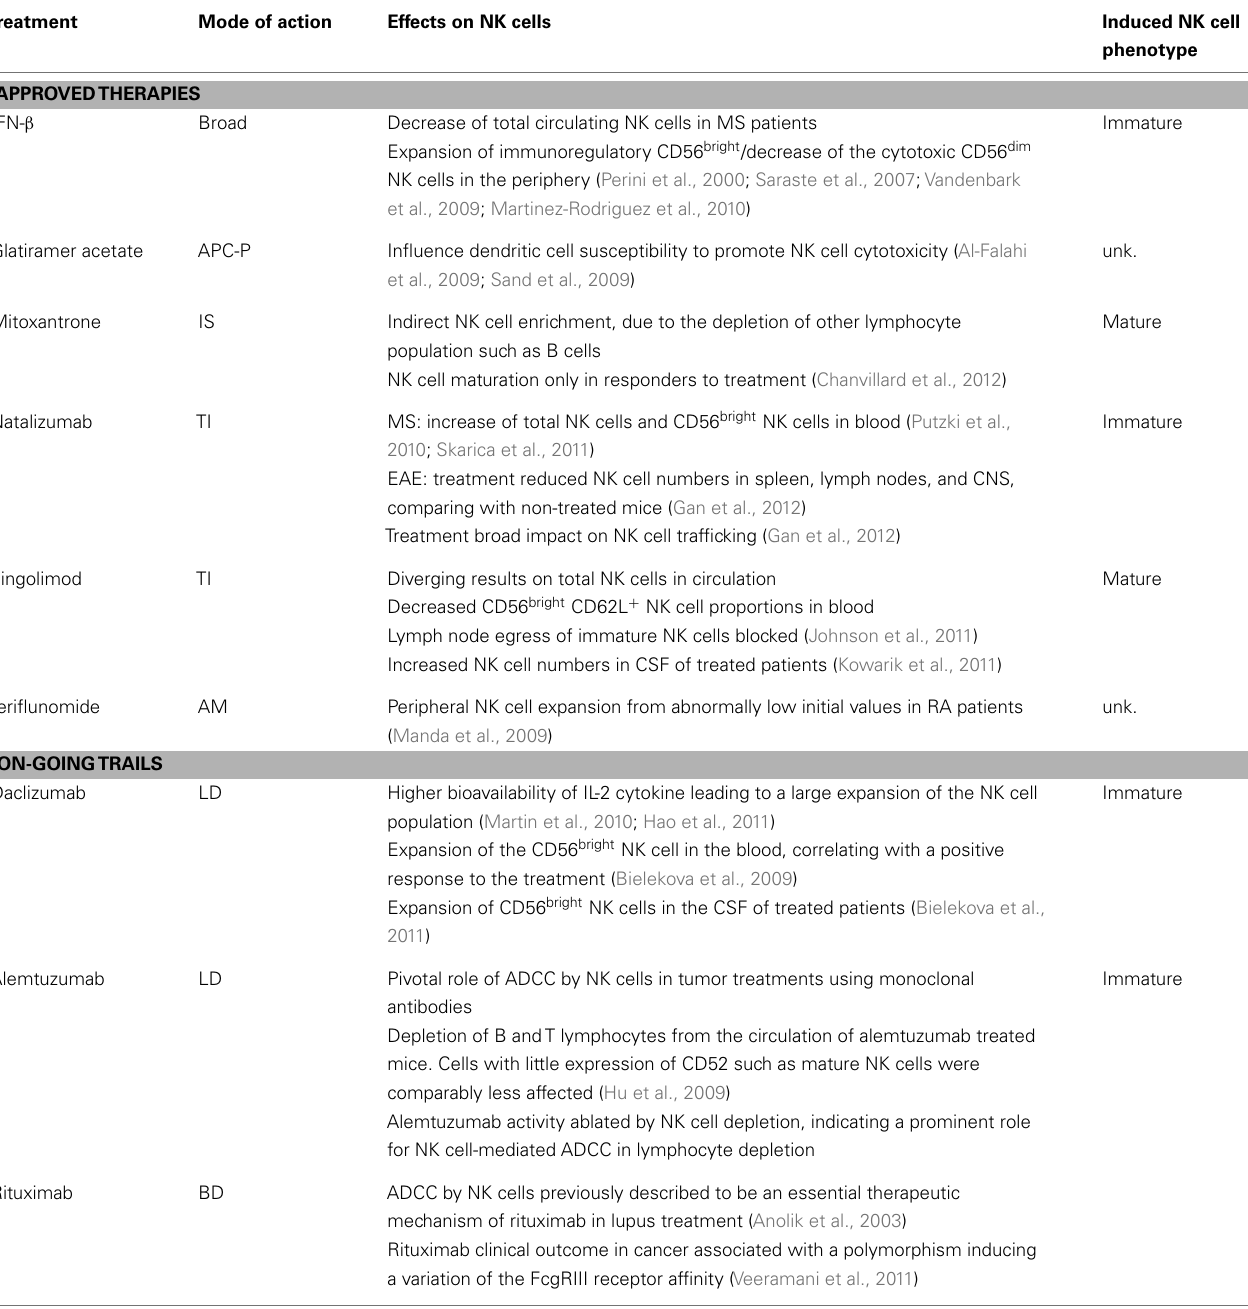
Table 1 | Overview of the effect of current and emerging MS therapies on NK